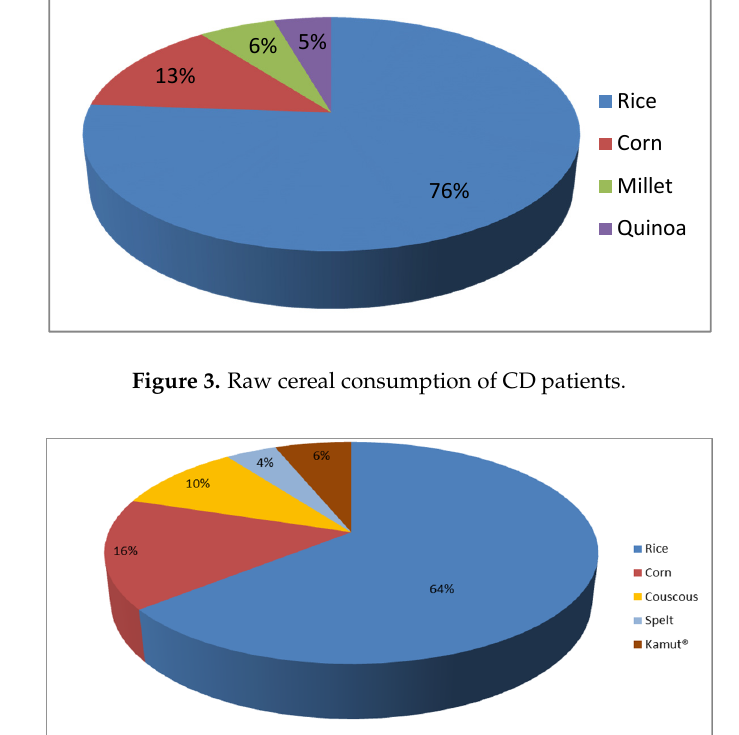
Figure 2. Daily cereal-based product consumption pattern in CD patients and controls according Figure 2. Daily cereal ‐ based product consumption pattern in CD patients and controls according to Figure 2. Daily cereal ‐ based product consumption pattern in CD patients and controls according to Figure 2. Daily cereal ‐ based product consumption pattern in CD patients and controls according to food processing: raw cereals (rice, polenta, other cereals) vs. processed cereal ‐ based products (sweet to food processing: raw cereals (rice, polenta, other cereals) vs. processed cereal-based products food processing: raw cereals (rice, polenta, other cereals) vs. processed cereal ‐ based products (sweet food processing: raw cereals (rice, polenta, other cereals) vs. processed cereal ‐ based products (sweet pastries, bread, pasta, homemade cakes, biscuits, crackers, breakfast cereals, and breadcrumbs). (sweet pastries, bread, pasta, homemade cakes, biscuits, crackers, breakfast cereals, and breadcrumbs). pastries, bread, pasta, homemade cakes, biscuits, crackers, breakfast cereals, and breadcrumbs). pastries, bread, pasta, homemade cakes, biscuits, crackers, breakfast cereals, and breadcrumbs).